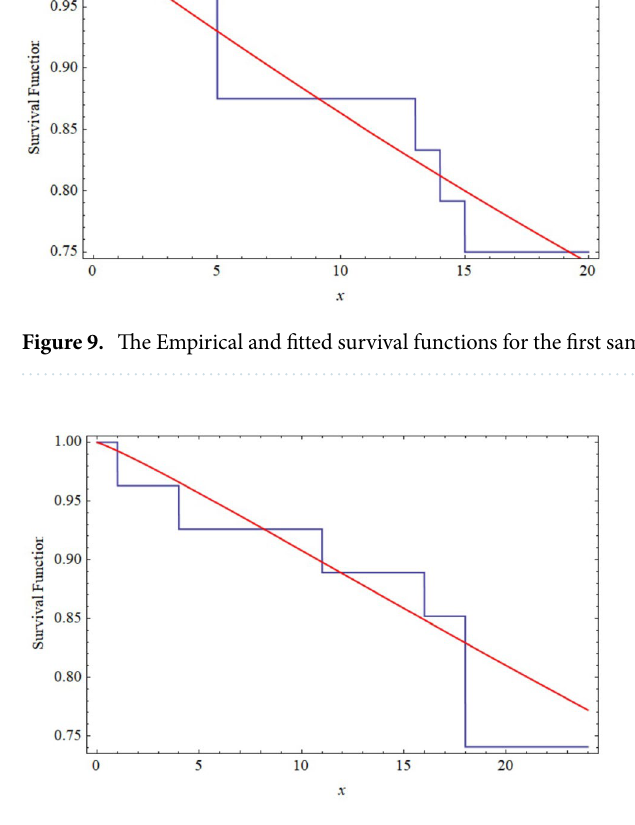
Figure 10. The Empirical and fitted survival functions for the second sample of real data.